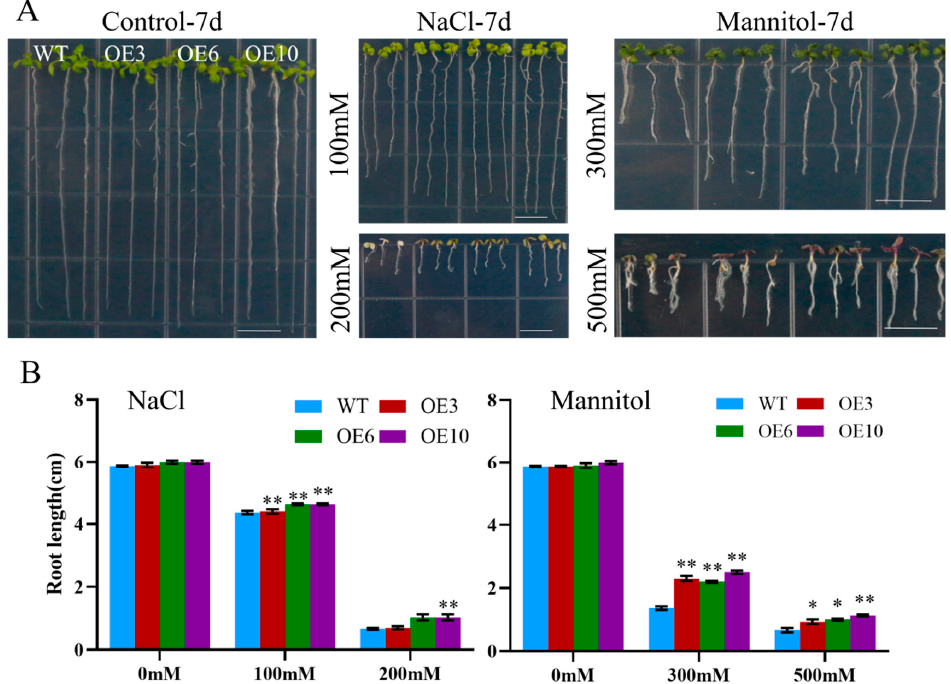
Figure 8. Assays of the length of the primary roots of WT and MiCOL16A transgenic lines under abiotic stress. ( A ) Seeds of the WT and three transgenic lines grown on half-strength MS media and subjected to various stresses. The bars represent 1.0 cm. ( B ) Lengths of the roots of all the lines under salt and drought treatment. Significant differences among the samples were assessed at the p < 0.05 (*) and p < 0.01 (**) levels by Student’s t tests.